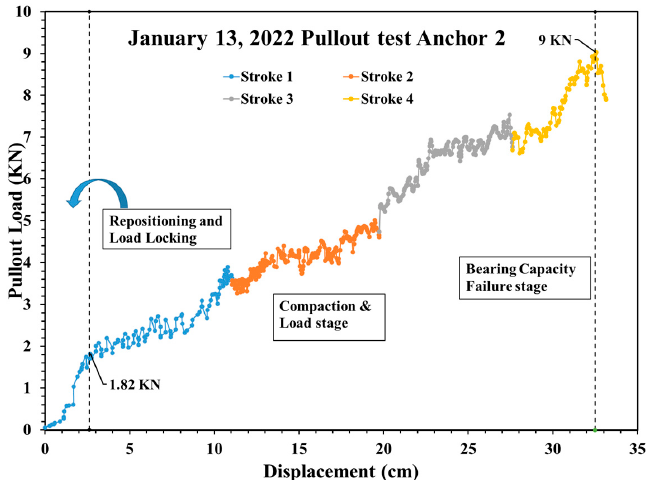
Figure 15. Anchor 2 pull-out test 2 repeat, southwest bank, 15 February 2022.